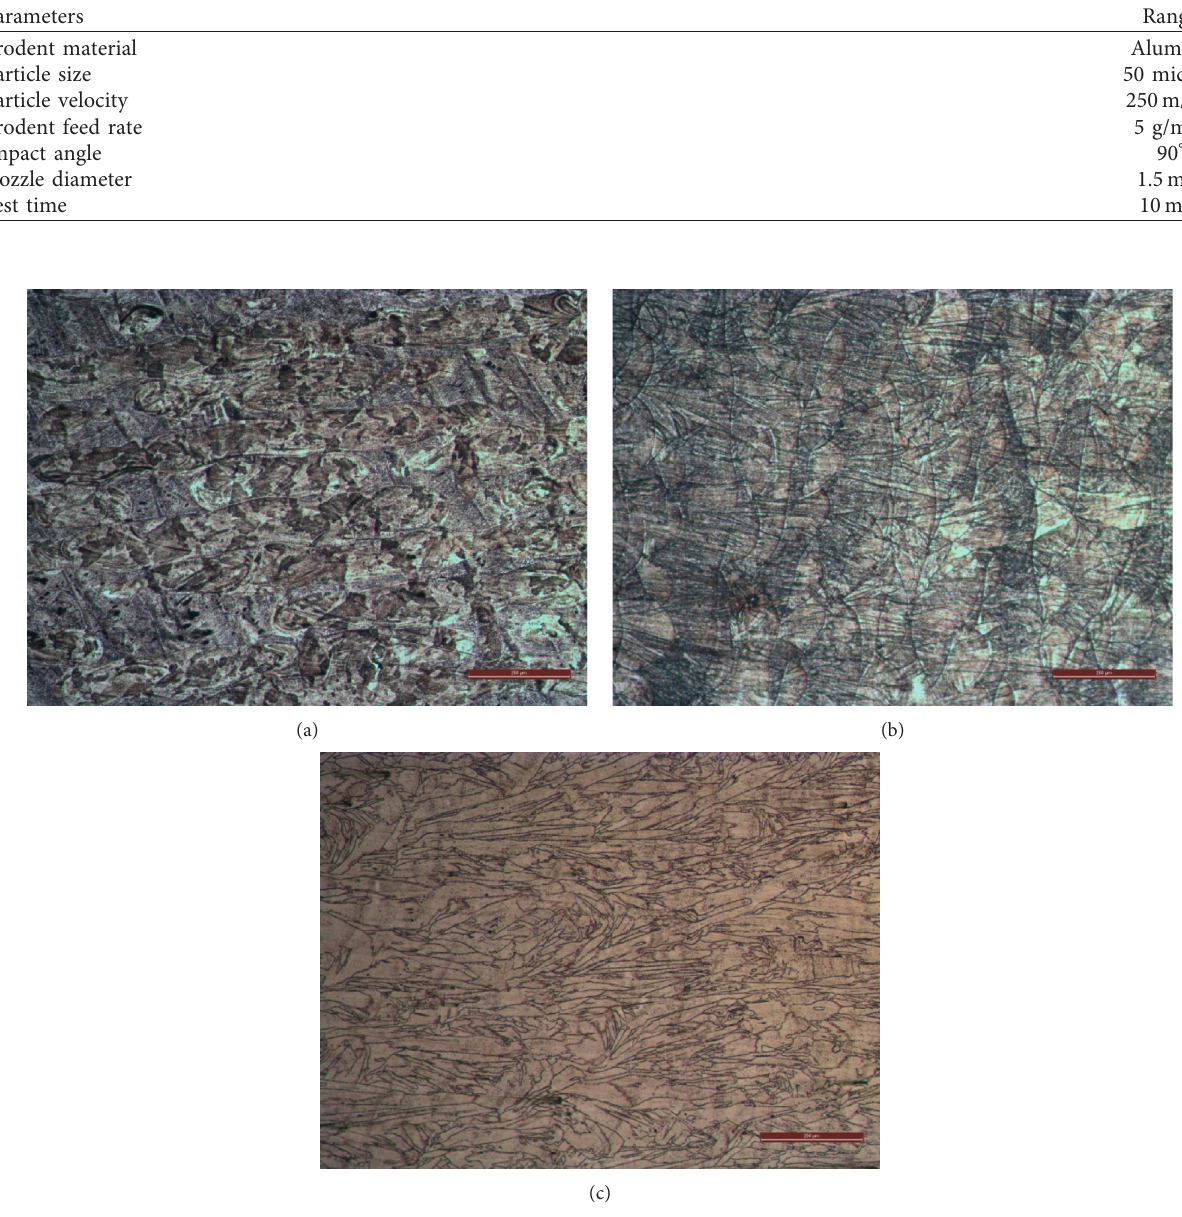
Figure 2: Optical microstructure of (a) as built, (b) HT 1, and (c) HT 2 DMLS alloy.